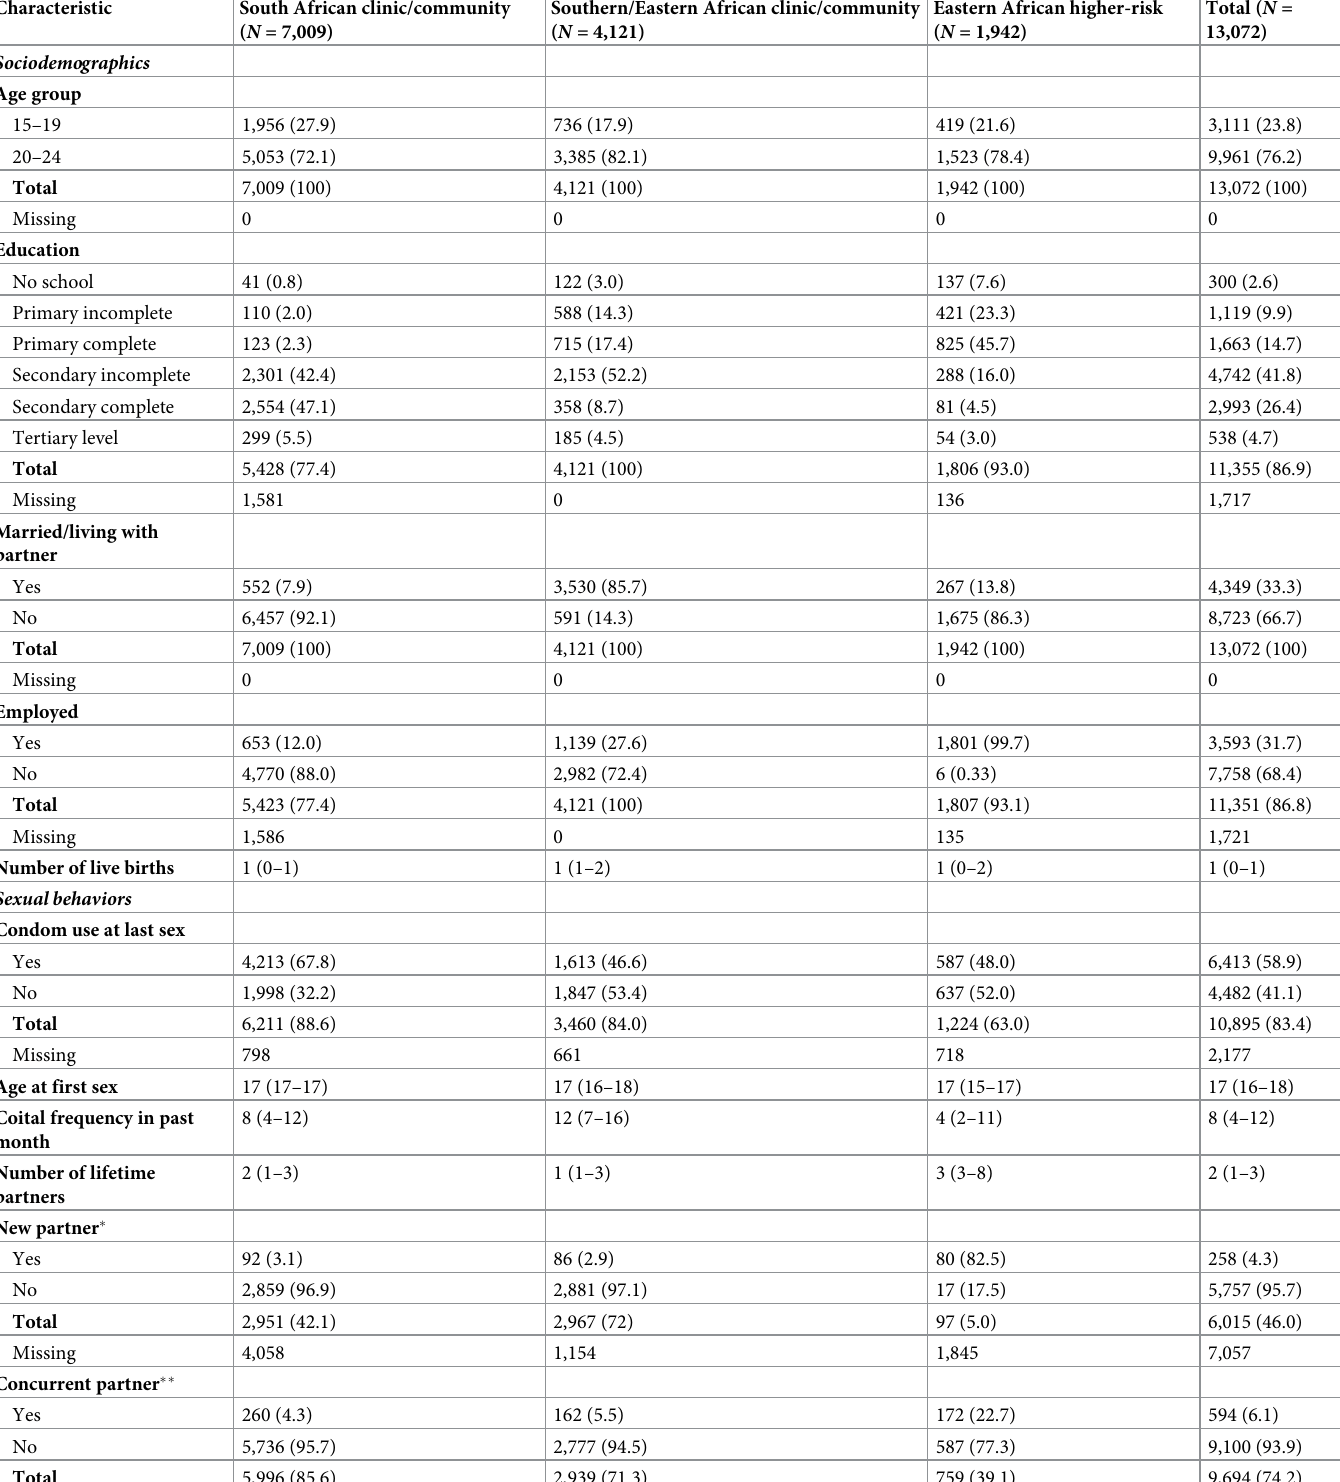
Table 2. Baseline characteristics by region/population type among participants aged 15–24